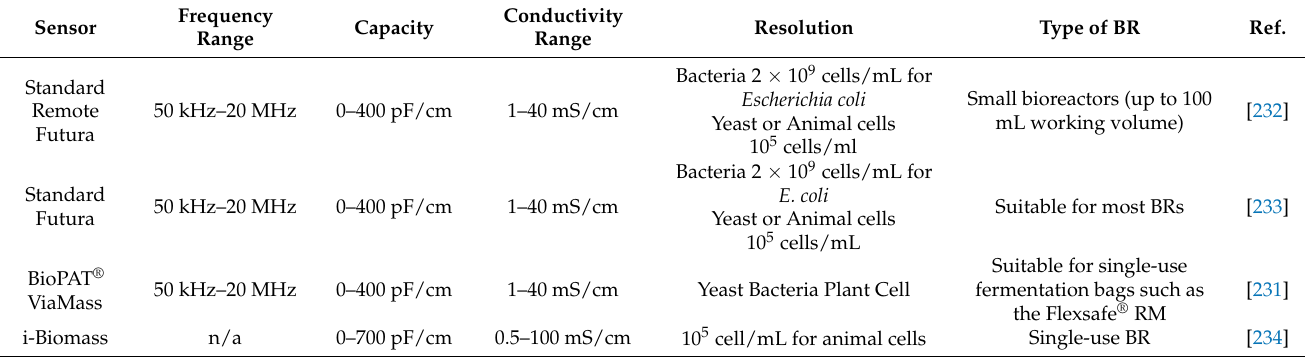
Table 6. Commercially available capacitive sensors for biomass. BR: